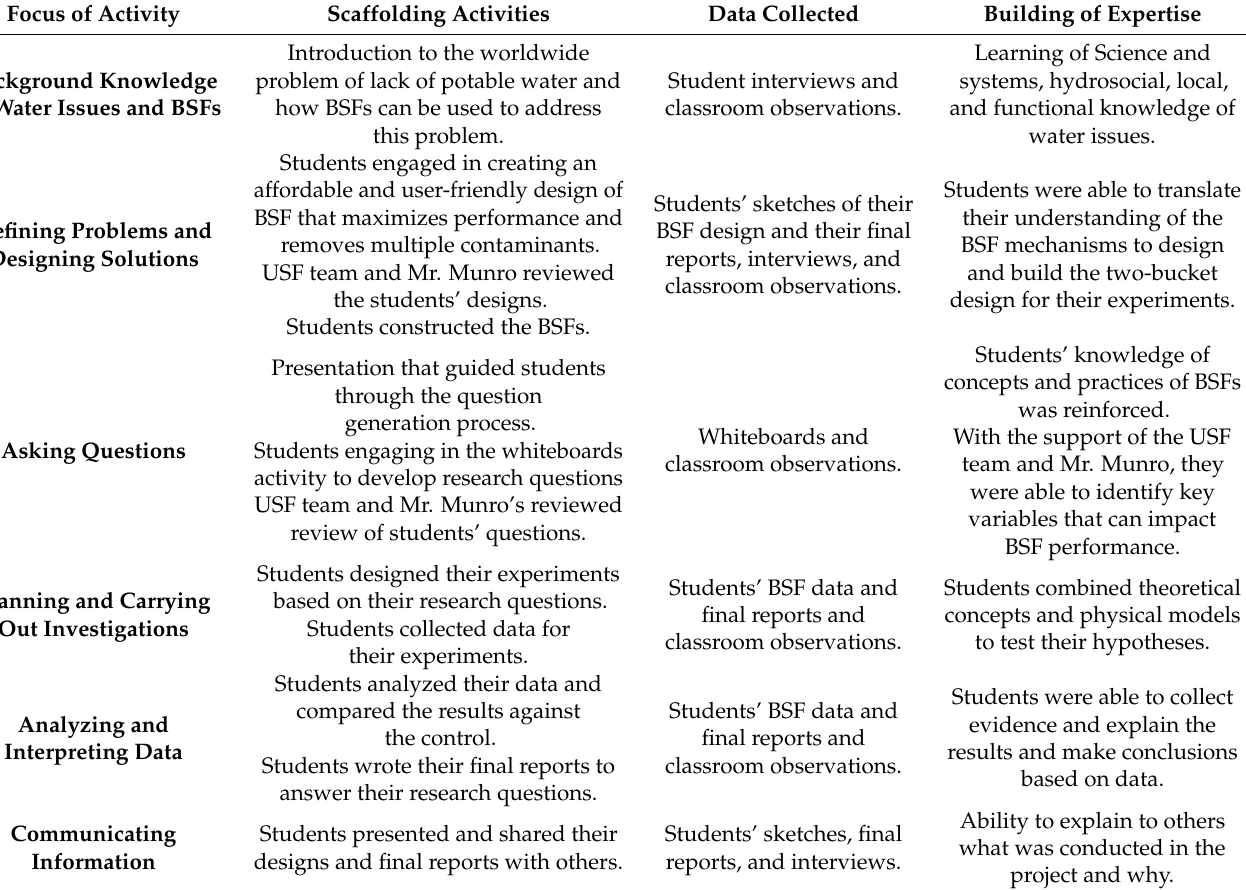
Table 1. Scaffolding activities and their relationships with science and engineering